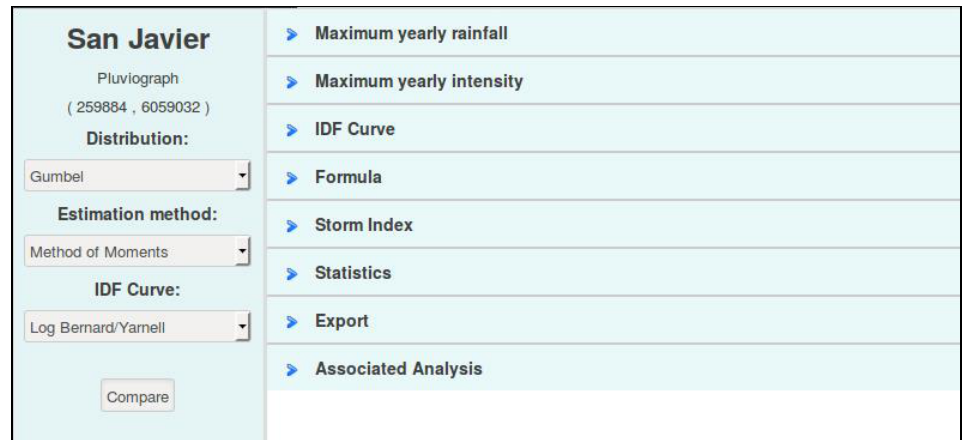
Figure 7. Visualization and analysis of rainfall intensity for a pluviographic gauge (San Javier) included in WEBSE IDF .